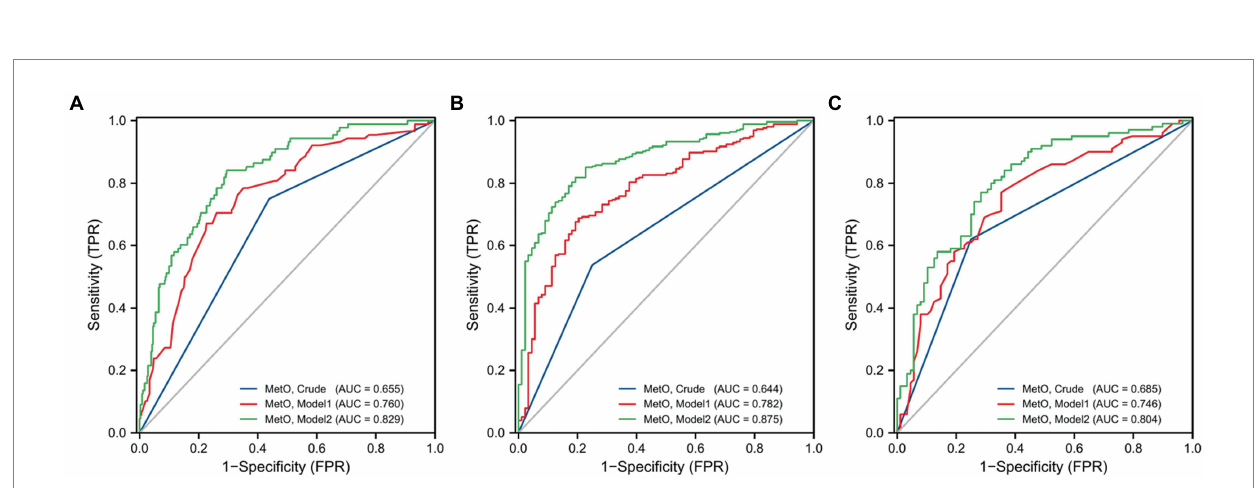
FIGURE 4 ROC curves of low and high levels of MetO in different models for the risk of MMD and its subtypes. (A) MMD overall; (B) Ischemic-type; (C) Hemorrhagic-type.